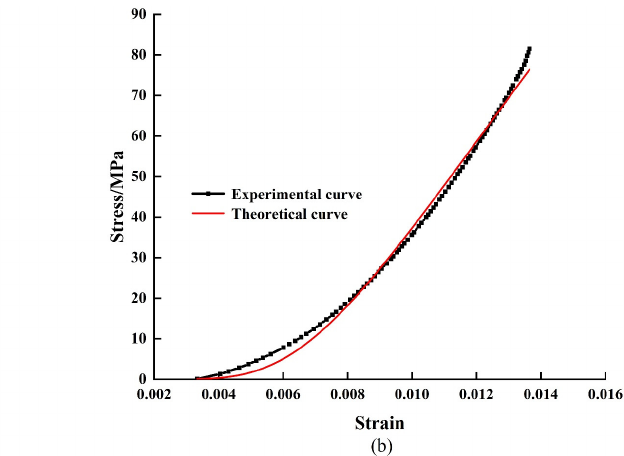
Figure 10. Unloading curve fitting: (a) 30 MPa. (b) 80 MPa.